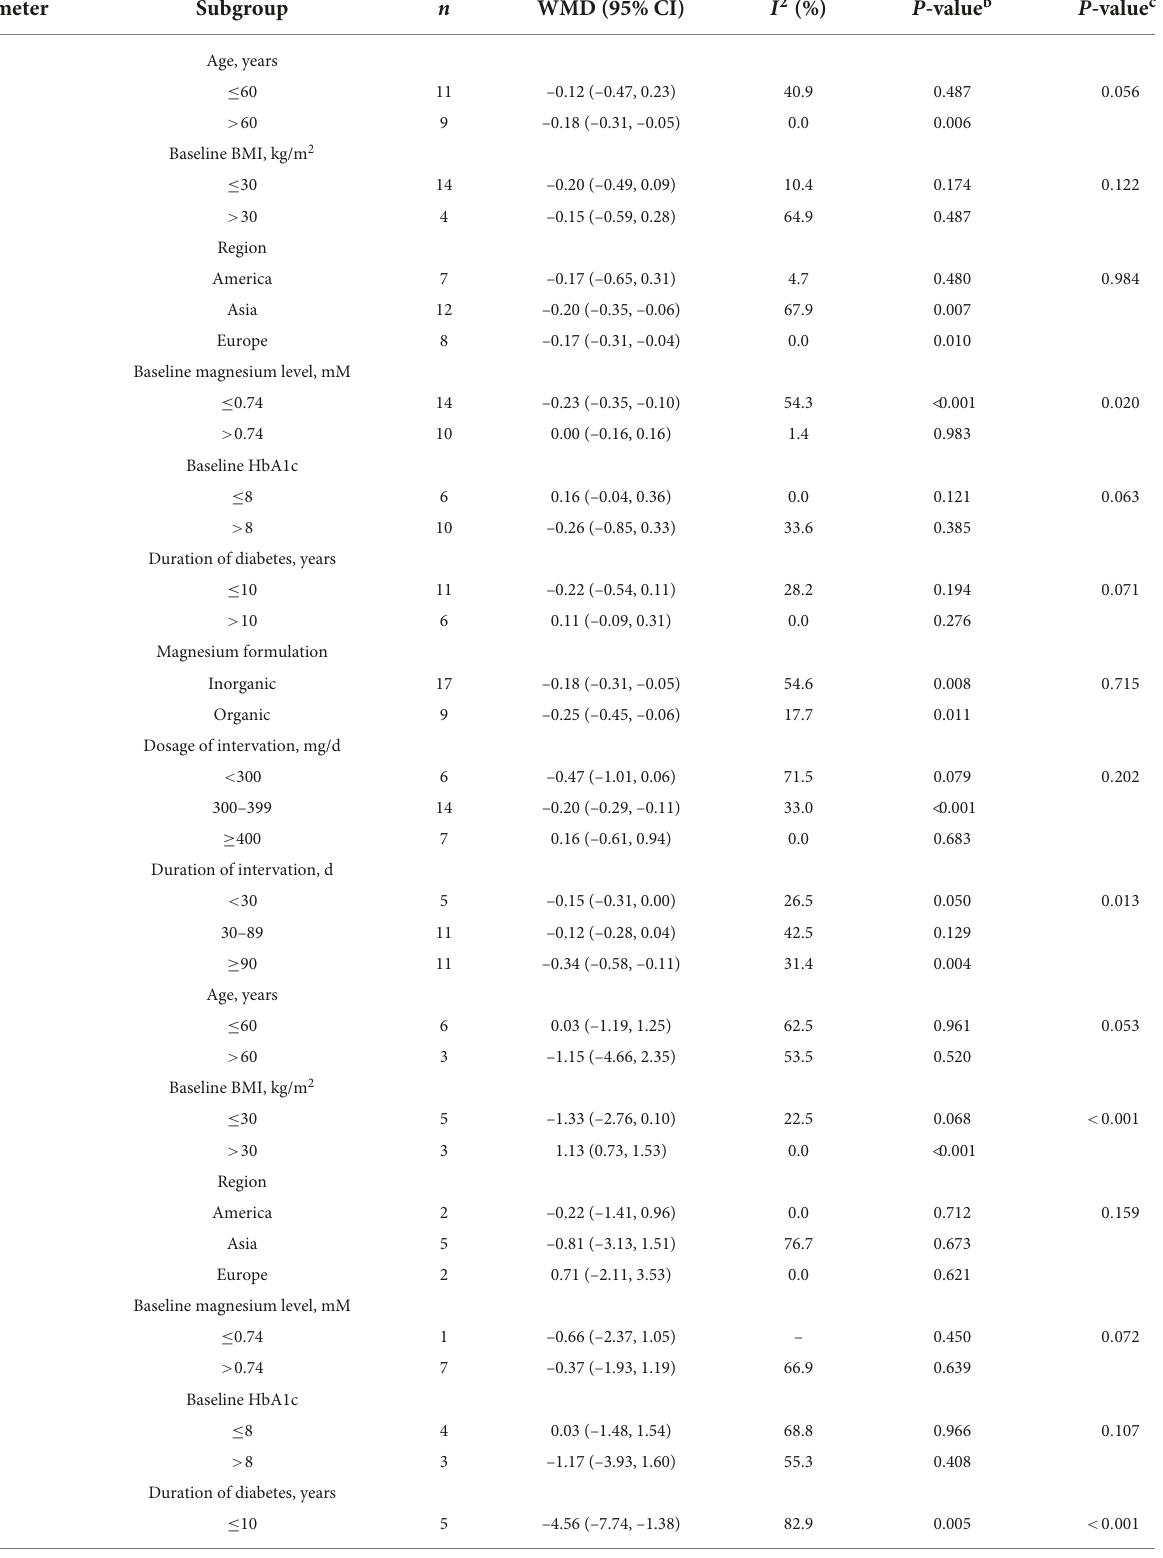
TABLE 2 Subgroup analyses for the effects of magnesium supplementation on glycemic, lipid and blood pressure parameters in type 2 diabetes mellitus patients a